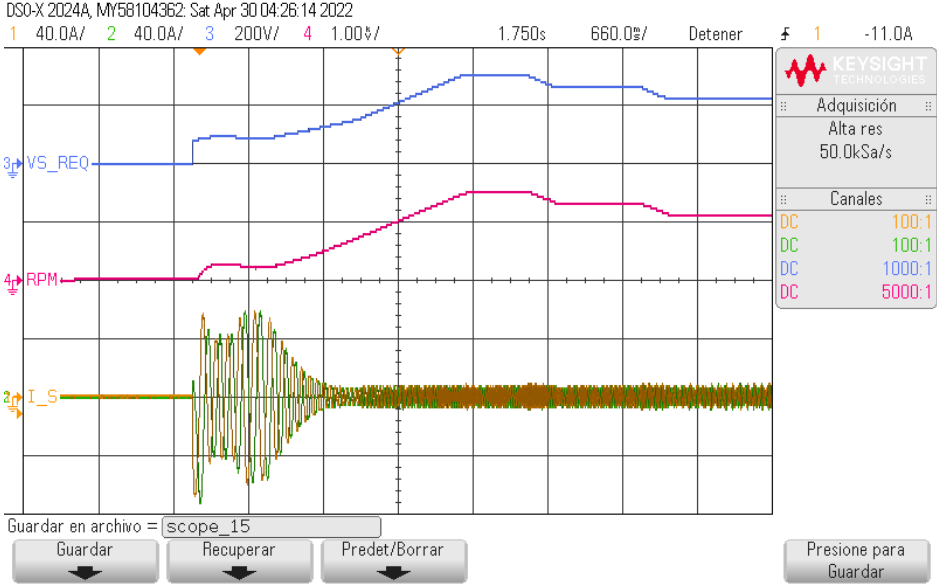
Figure 4. Oscilloscope waveforms of V ∗ s , ω r , and i a and i b , for the standard HST-SCS